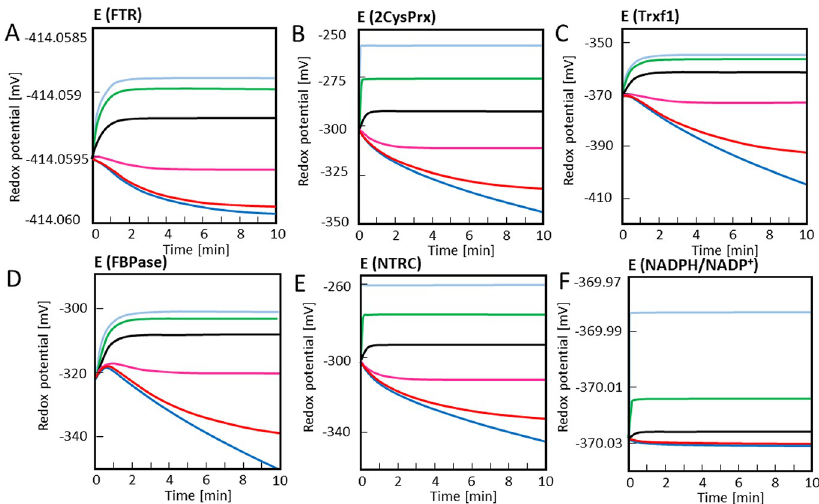
Fig 6. Time-dependent simulation of redox potentials of FTR/FNR-network components. The redox potentials of FTR/FNR-network components were simulated and included FDX, FNR, NADPH, NTRC, FTR, TRX-f1, FBPase and 2CysPRX. Redox potentials were calculated at each time step using the Nernst equation for (A) FTR, (B) 2CysPRX, (C) Trx-f, (D) FBPase, (E) NTRC and (F) NADPH/NADP + couple. The simulation was run for 10 min at constant H 2 O 2 concentrations of 0 μ M (blue), 1 nM (red), 10 nM (magenta), 100 nM (black), 1 μ M (green) and 10 μ M (cyan).